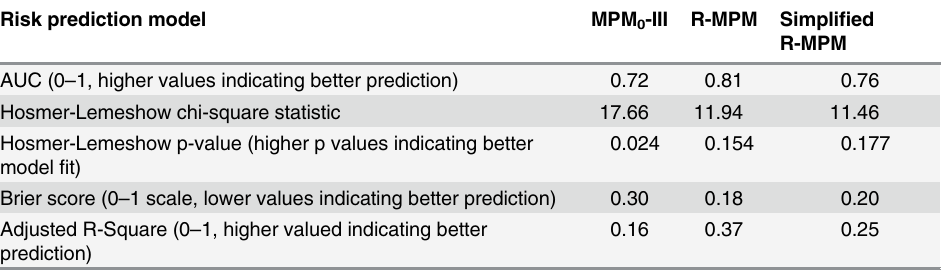
Table 4. Discrimination and calibration of three risk prediction models in a Rwandan ICU population.